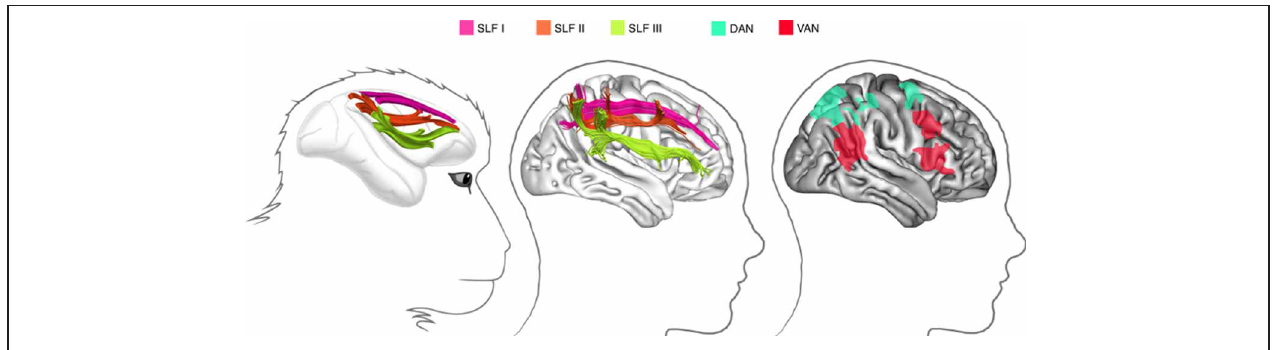
FIGURE 1 | Fronto-parietal networks linked by the three branches of the superior longitudinal fasciculus. Left: in the monkey brain (from Schmahmann and Pandya, 2006): middle: in the human